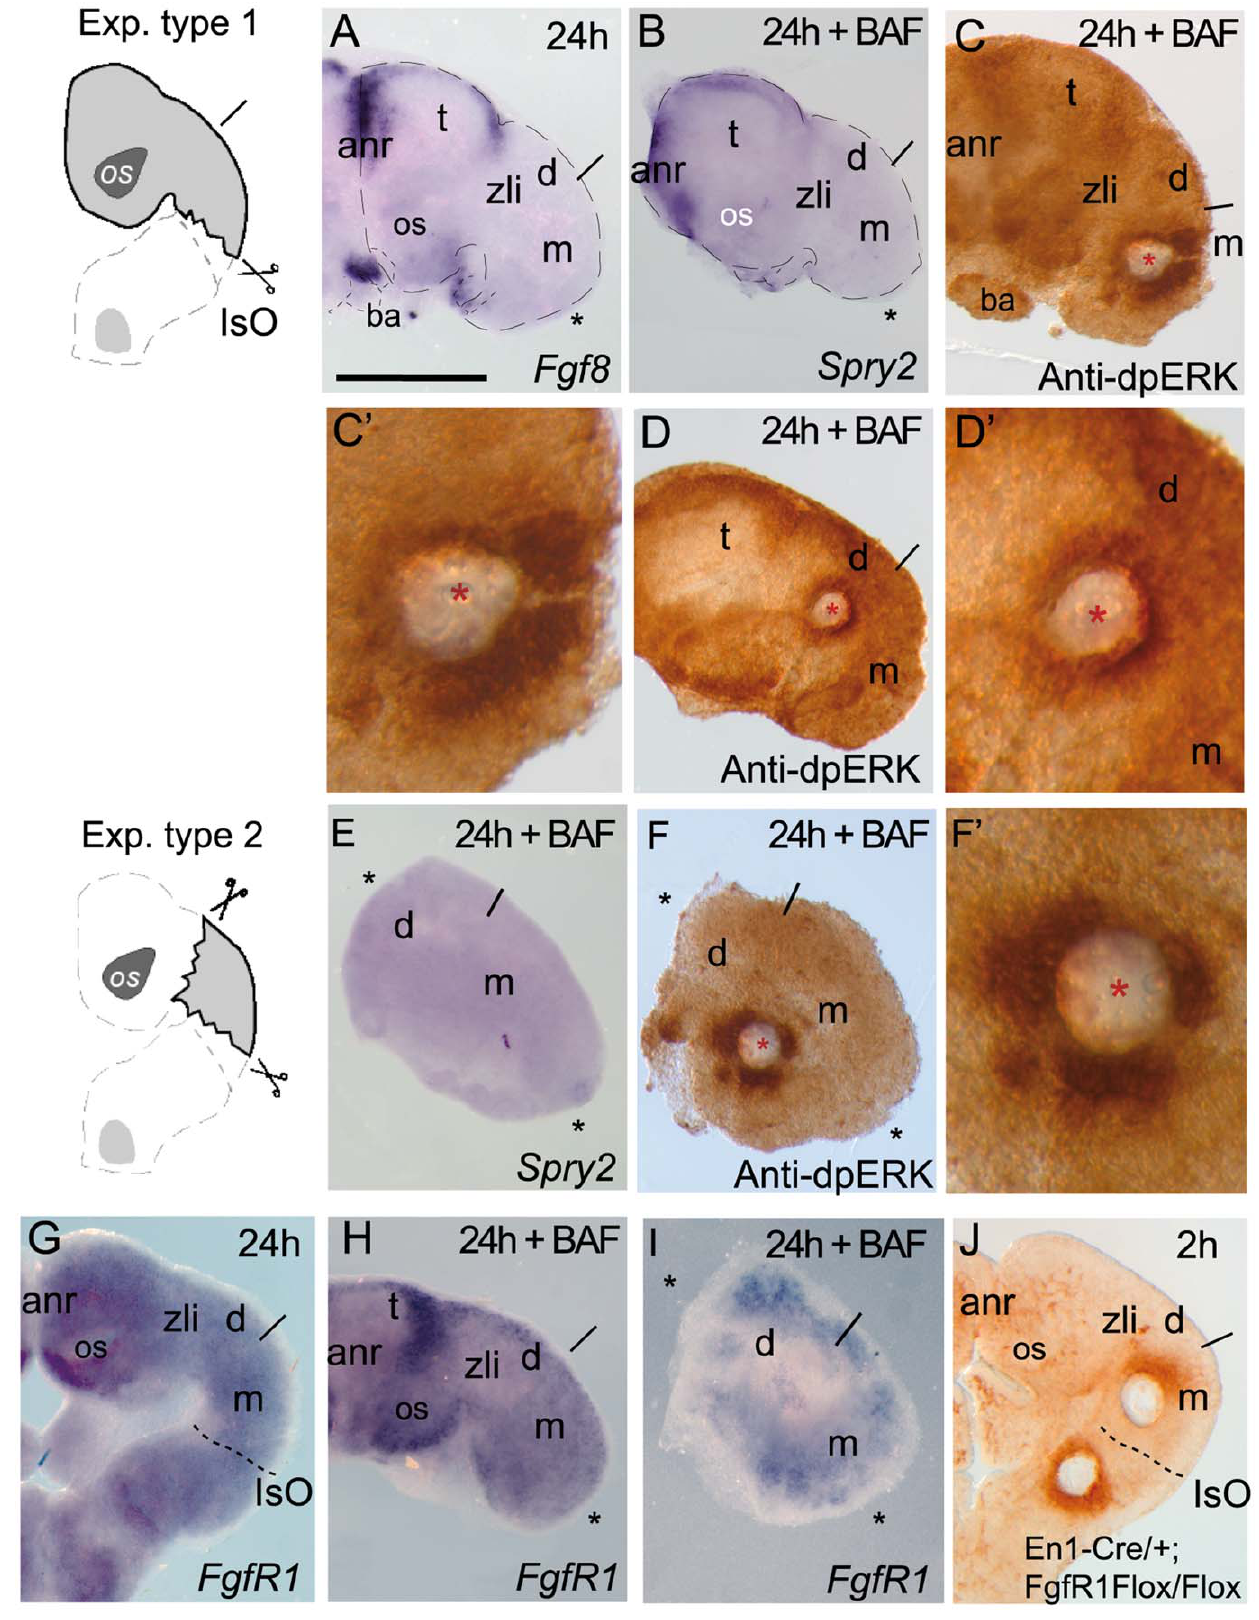
Figure 5 . The position of FGF8- related secondary organizers determines the polarity of ERK1/2 activation . A-D’) show the type 1 experimental manipulation in ONTCs where a dissection of the IsO region was made, left for 24 hours in vitro and thereafter it was incubated with